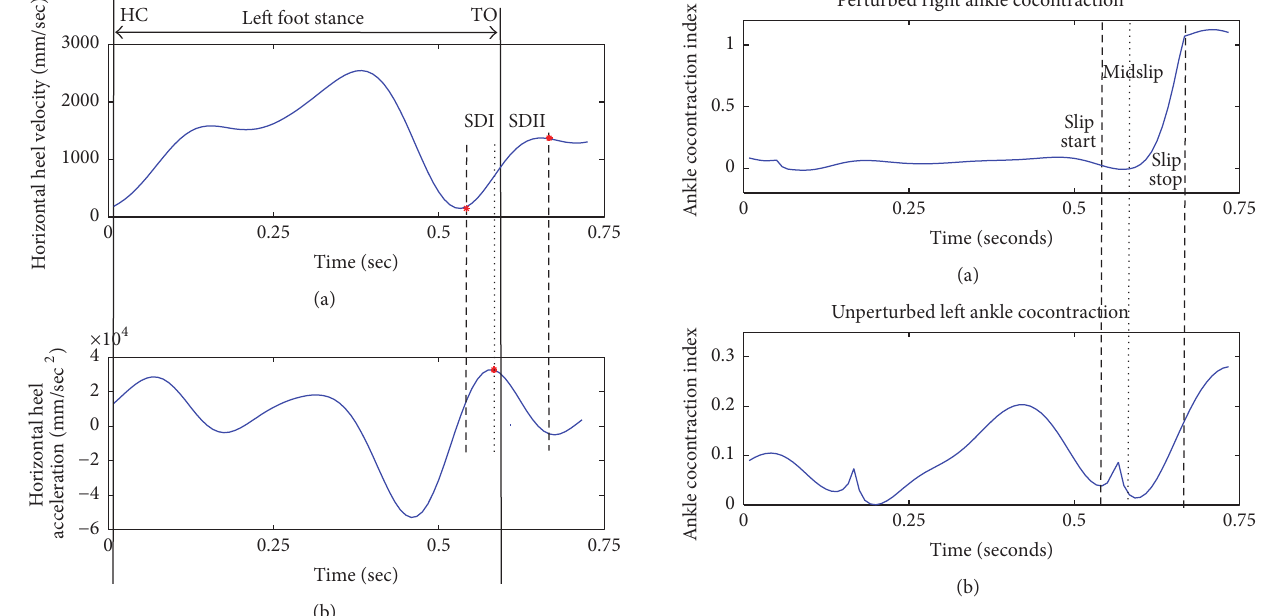
Figure 4: (a) Ankle cocontraction values in the slipping foot. (b) Ankle cocontraction values in nonslipping